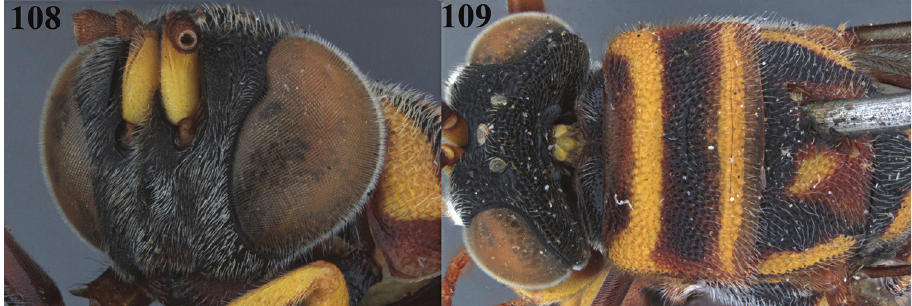
Figures 108, 109. Leucospis bakeri Crawford, ♀ , holotype. 108 Head antero-lateral 109 pronotum dorsal (courtesy of Dr. Elijah Talamas, Smithsonian Institution, Washington DC, USA).